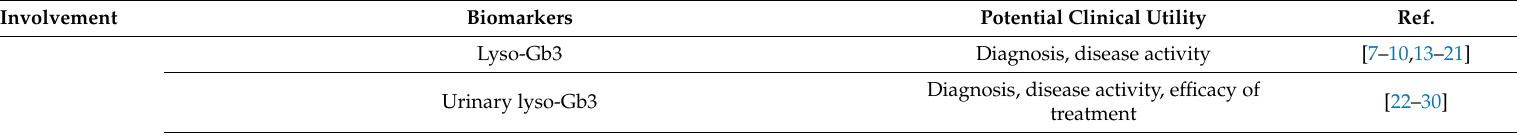
Table 1. Biomarkers and their potential clinical utilities in Anderson-Fabry